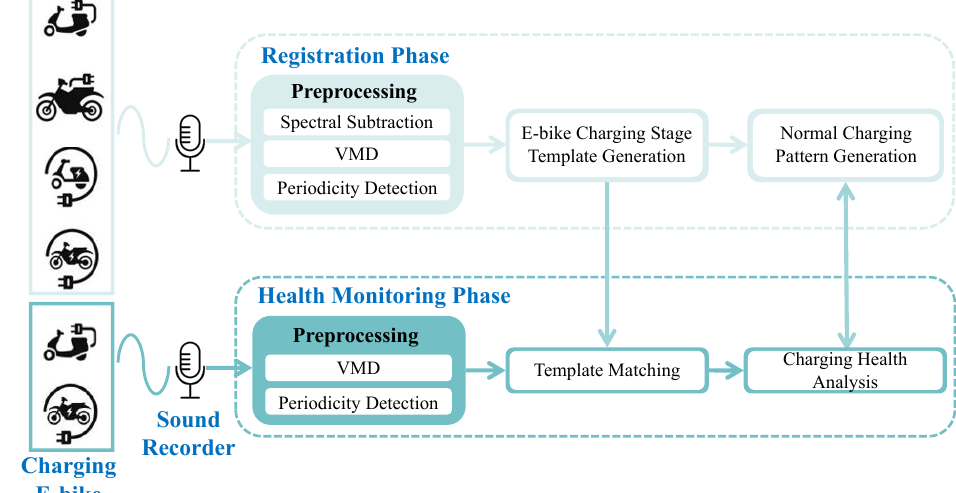
Figure 12. System overview of SingMonitor